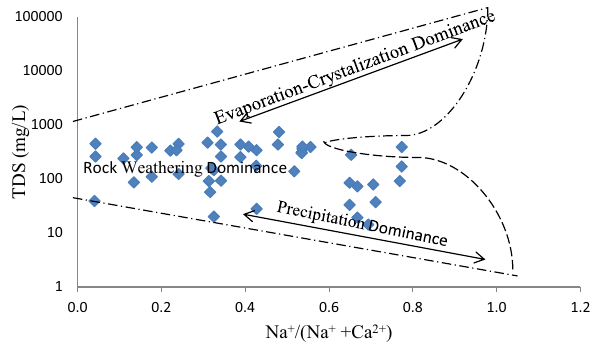
Fig. 5 Scatter plot of TDS (mg/L) against Na + /(Na + + Ca 2+ ) (meq/L) showing rock weathering and precipitation